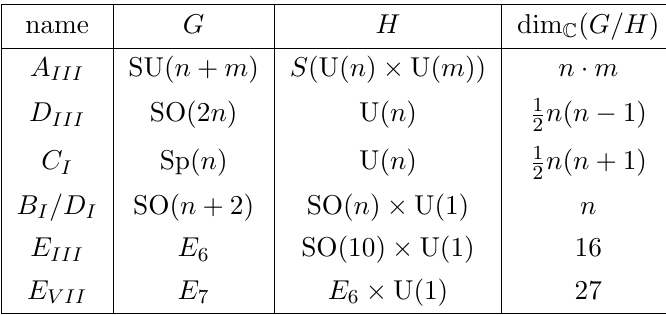
, D , C , B =D , and the III III I I I